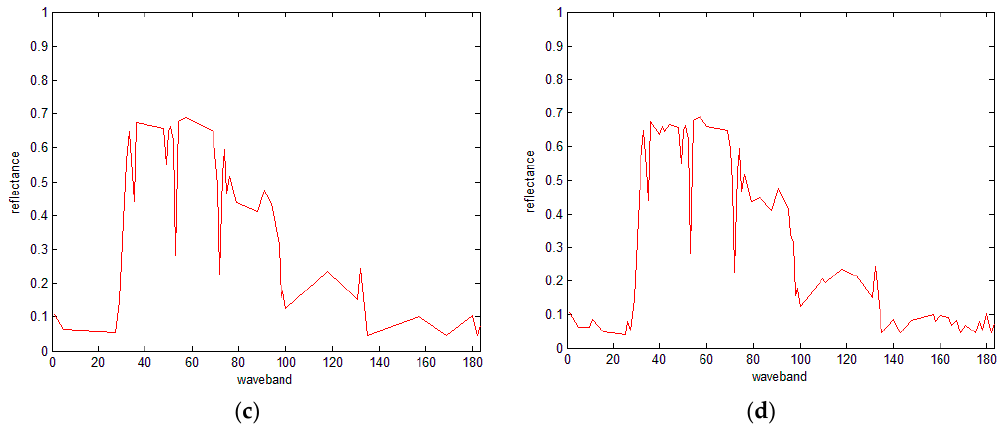
Figure 4. The simplified spectral curves using the IDP algorithm with different numbers. ( a ) The original spectral curve with 183 points, ( b ) 13 retained points, ( c ) 40 retained points, and ( d ) 70 retained points.